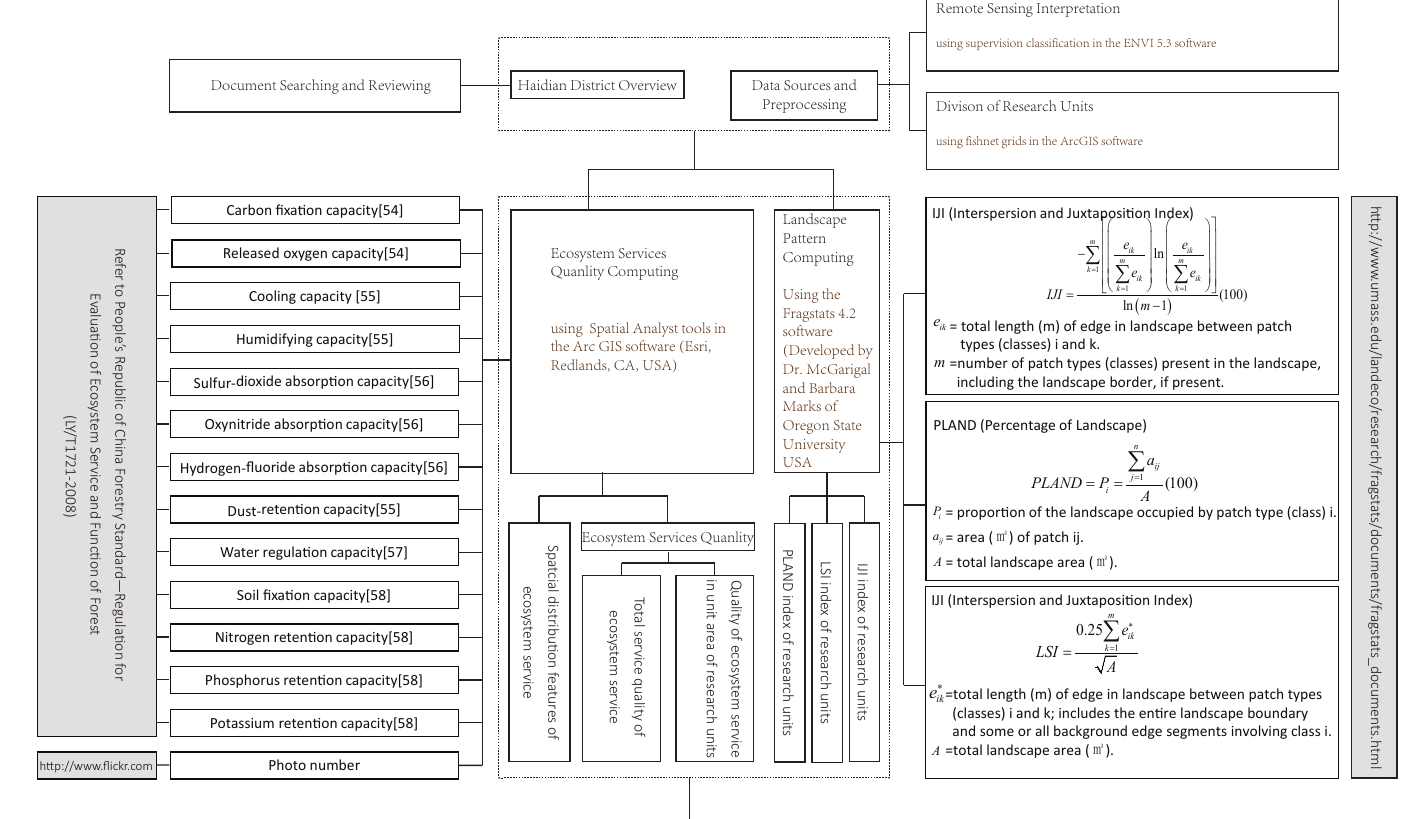
= total landscape area ( ㎡ ).